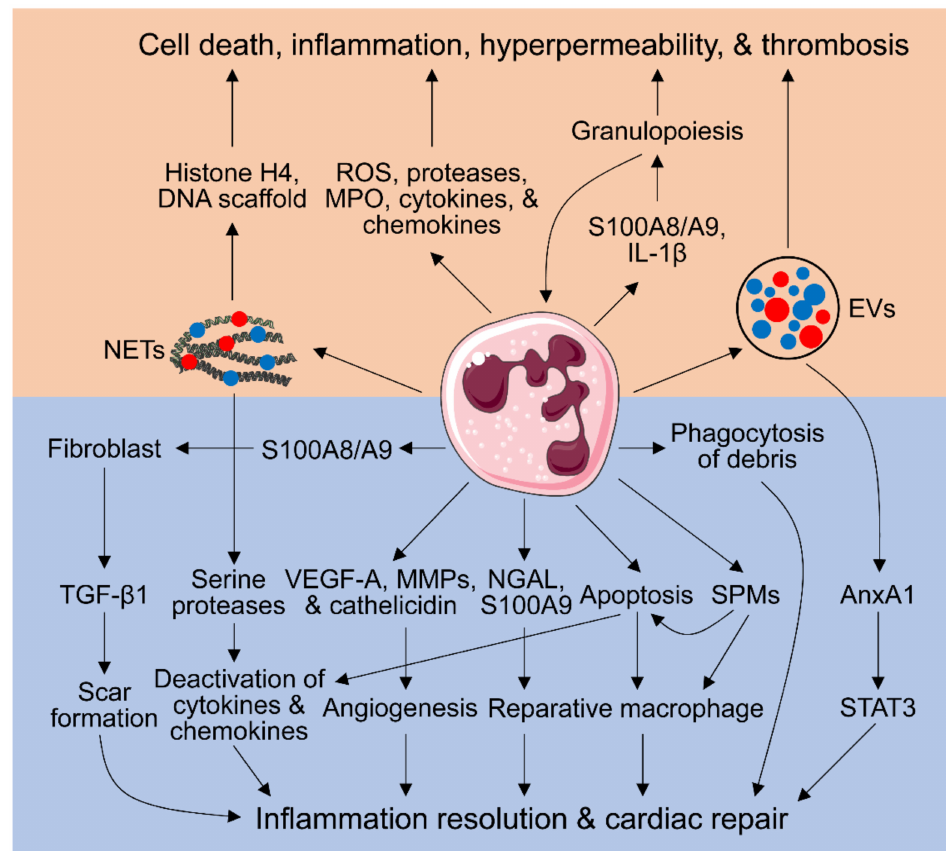
Figure 1. Detrimental and beneficial roles of neutrophils in myocardial infarction (MI) wound healing. It is well known that neutrophils can promote myocardial injury by releasing reactive oxygen species (ROS), granular components, and pro-inflammatory mediators. Recent studies show that neutrophils are able to form extracellular traps (NETs) and produce extracellular vesicles (EVs) to increase inflammation and cardiac injury. In addition, neutrophils enhance granulopoiesis, forming a positive feed-forward loop for neutrophil production and acute inflammation. On the contrary, emerging evidence reveals that neutrophils are indispensable for appropriate wound healing after MI. They promote inflammation resolution, angiogenesis, and scar formation by generating a wide array of pro-reparative factors, including neutrophil gelatinase-associated lipocalin (NGAL), vascular endothelial growth factor-A (VEGF-A), cathelicidin, annexin A1 (AnxA1), and specialized pro- resolving mediators (SPMs). MPO, myeloperoxidase; MMPs, matrix metalloproteinases. The red and blue dots represent different proteins or other molecules. Images of cells are from Servier Medical ART (Accessed date 1 June 2021